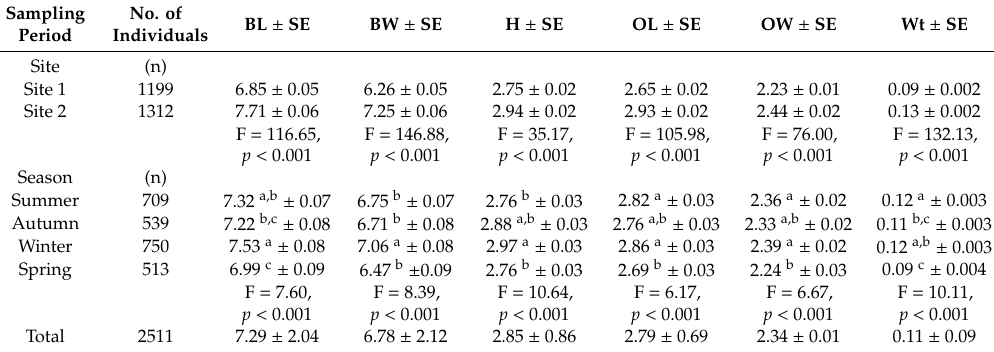
Table 2. Spatial and temporal variation of the biometric characters, number (n), basal length (BL), basal width (BW), height (H), opercular length (OL), opercular width (OW), weight (Wt), represented as mean value ± standard error (SE), one-way ANOVA results (F, P ) and Tukey’s pairwise comparisons, of C. stellatus populations in Pagasitikos Gulf.